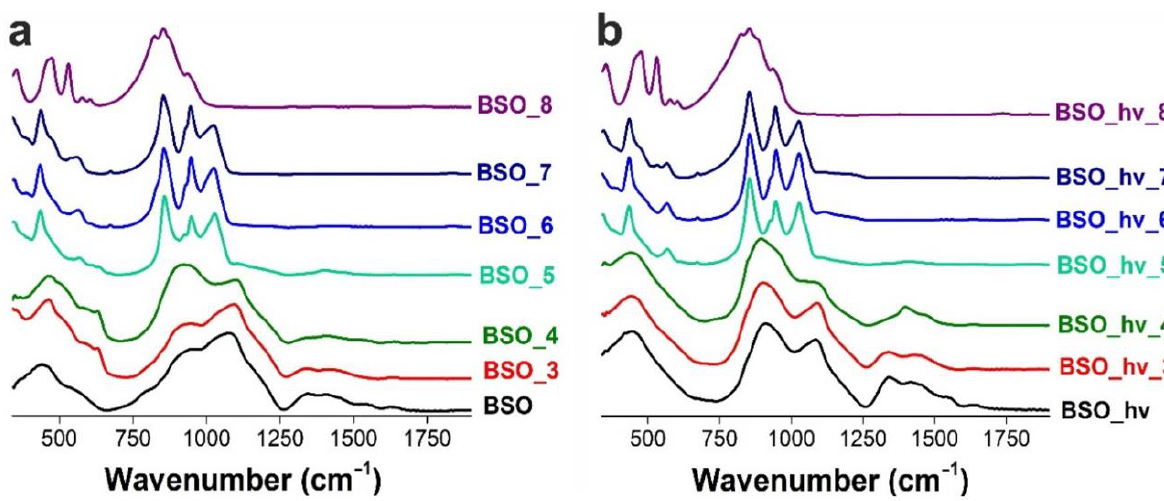
Figure 6. FTIR spectra of the BSO ( a ) and BSO_hν ( b ) groups of materials. Spectra for samples treated at 200 °C are identical to those of initial samples.